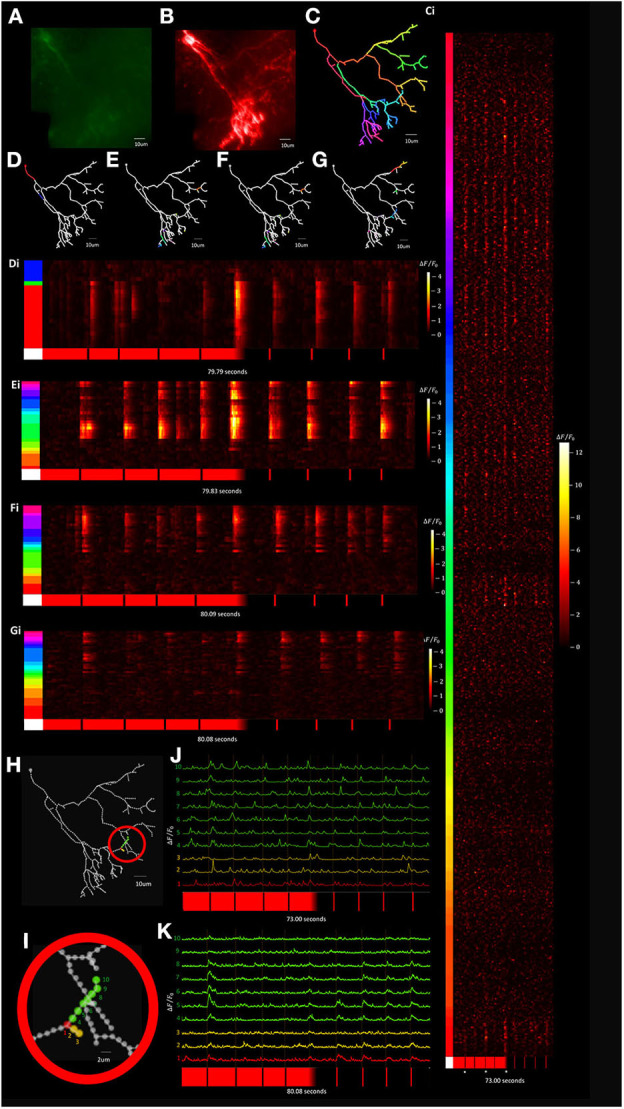
Visually evoked tectal neural activity can be recorded across the complete dendritic arbor and soma using random access TPLSM. (A,B) A standard deviation projection image in the green (A) and red channels (B) of a Xenopus tectal neuron expressing jGCaMP7s and mCyRFP created from a F3DS stack of images is shown. (C) The user-drawn POIs tracing out the structure of the neuron. A total of 609 POIs are drawn located at 2 μm distances from their nearest neighbor. (Ci) ΔF/F0 output from the resulting F3DS of the 609 POIs, collected at 3 Hz over a 73 second interval. Responses can be seen for four 50 ms “OFF” stimuli, a “transition shift” stimulus and four 50 ms “ON” stimuli at spaced at pseudorandom time points. White asterisks indicate evoked somatic events. (D–G) The user-drawn POIs tracing out the structure of the neuron with the colored POIs sampled using a series of planar RS
(Di-Gi) collected between 204 and 246 Hz with a similar experimental protocol as used previously (C-Ci). (H–I) A series of POIs that were recorded in both a 3 Hz F3DS scan and 232 Hz planar RS. (J) The traces for the POIs recorded at 3 Hz over 73.00 s. (K) The traces for the POIs recorded at 232 Hz over 80.08 s.